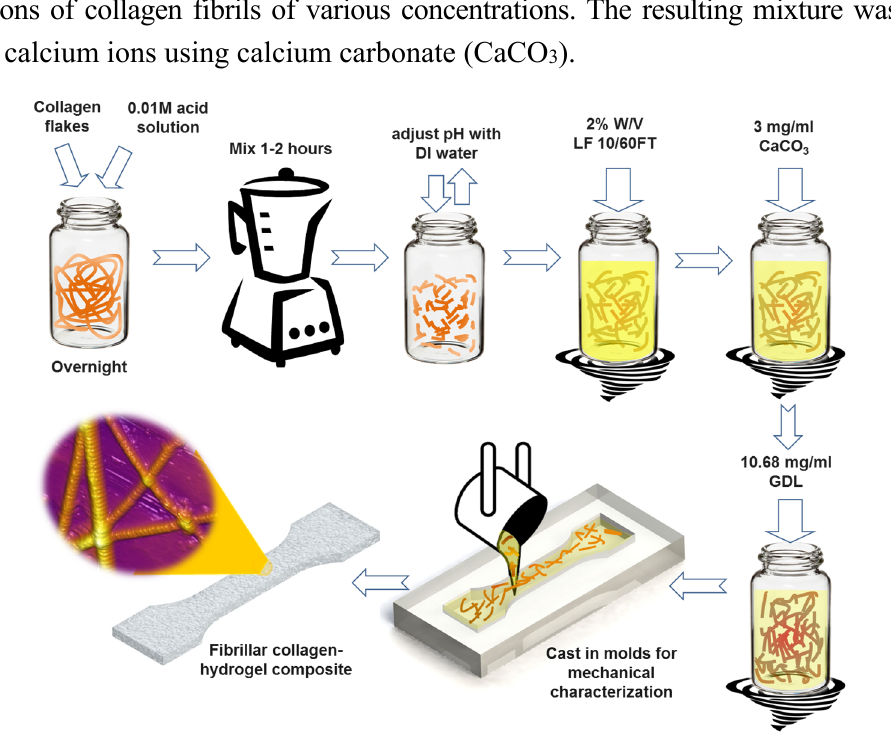
Figure 1. Schematic of the step-by-step preparation process of hybrid fibrous composite hydrogel with incorporation of native type I collagen fibrils. LF 10/60FT is a sodium alginate from FMC Biopolymer (Philadelphia, PA, USA), GDL is D -(+)-Gloconic acid δ -lactone. See Experimental